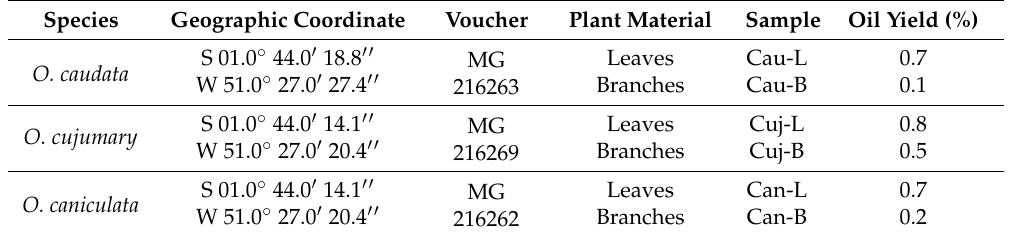
Table 1. Collection data and essential oil yield of the samples of Ocotea occurring in Caxiuan ã National Forest, Amazon,